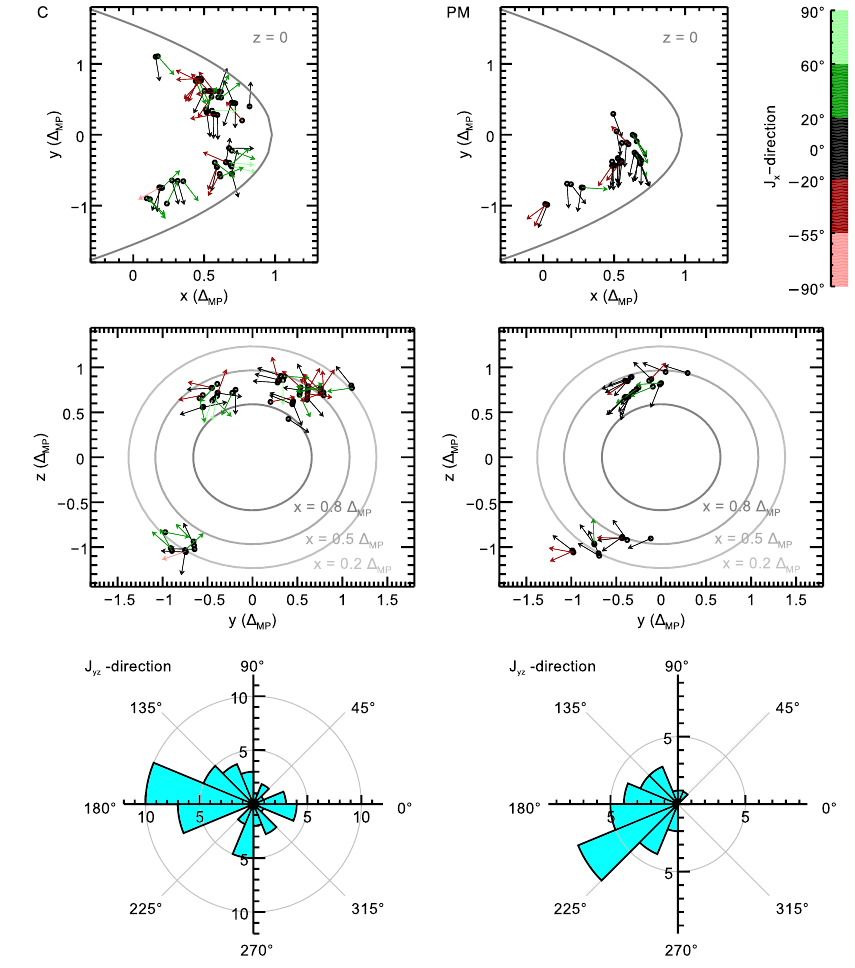
Figure 10. Same as Fig. 8 but for C (left) and PM (right)